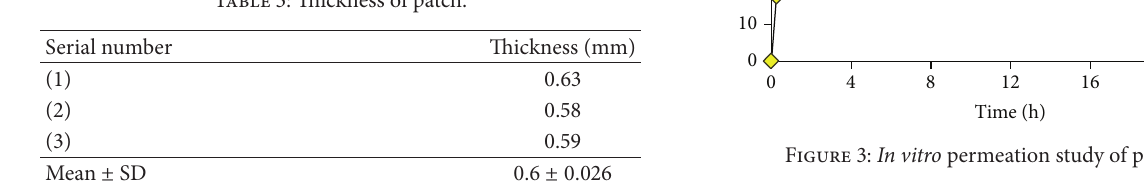
Table 3: Thickness of patch.